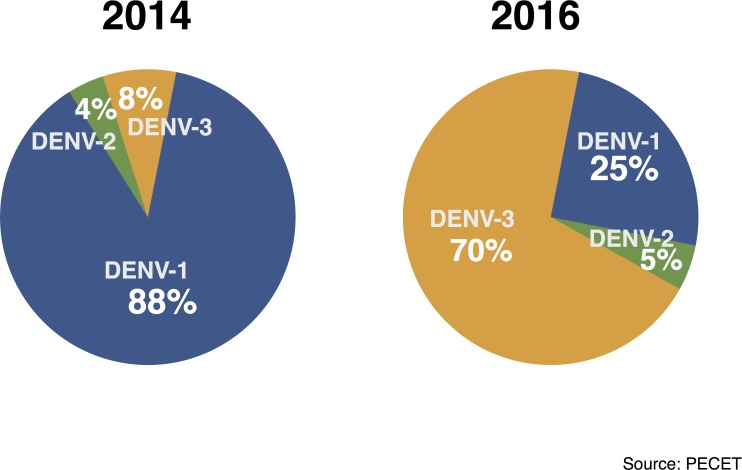
Barrio Paris, Colombia.DENV serotype distribution. The proportion of laboratory confirmed dengue cases by serotype from the fever clinic in the Paris neighborhood of Bello, Colombia. Surveillance began May of 2014 and ended in January of 2016.